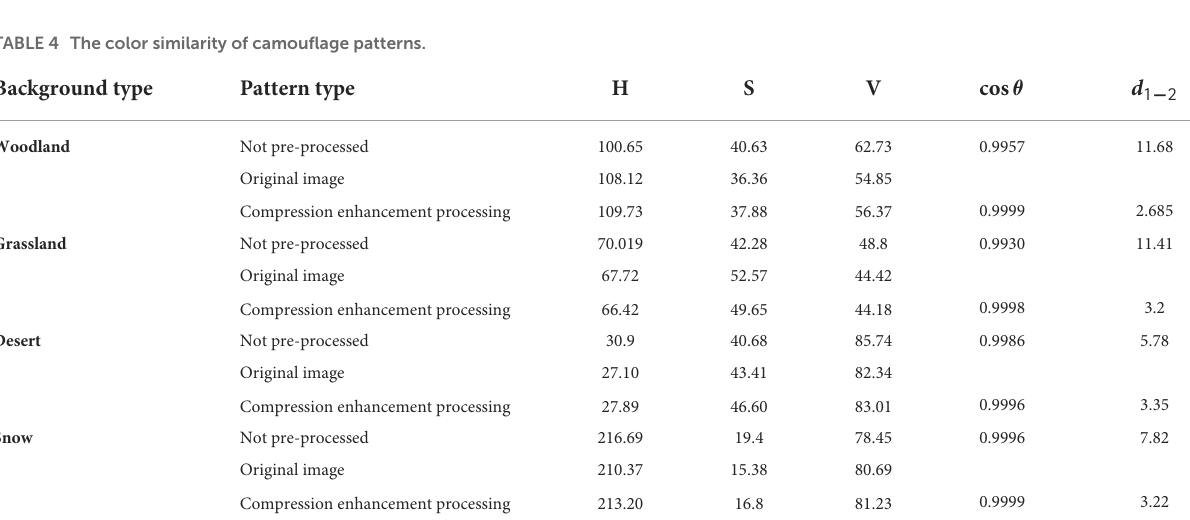
TABLE 4 The color similarity of camouflage